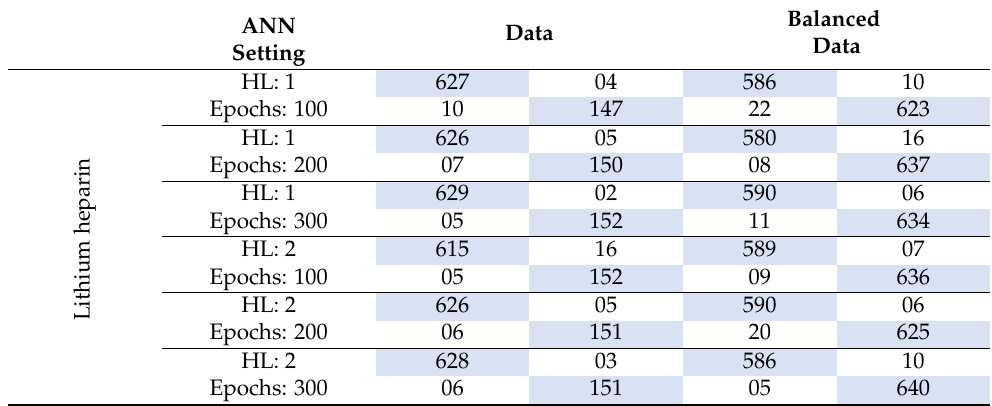
Table 9. Confusion matrix for each scenario. SF in tubes with lithium